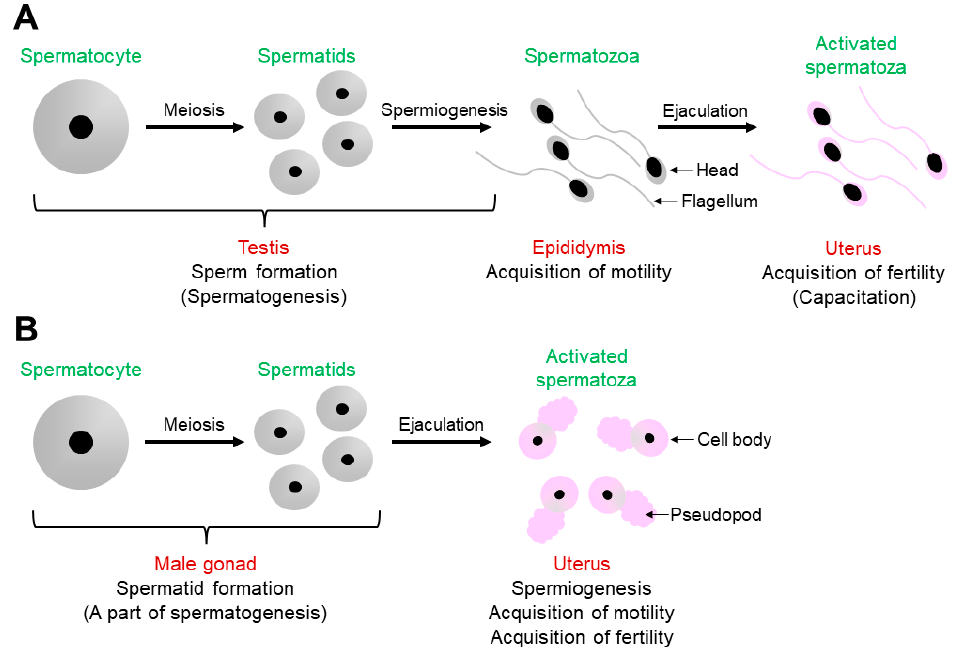
Figure 1. Comparison of sperm formation and activation in mice and C. elegans . ( A ) In the mouse testis, spermatozoa are produced during spermatogenesis. The testicular spermatozoa acquire their motility during transition in the epididymis. After ejaculation, the epididymal spermatozoa undergo capacitation to gain the ability to fertilize oocytes. ( B ) Meanwhile, in the C. elegans male gonad, round spermatids are produced via meiosis; however, spermatogenesis is arrested at this stage. After mating, in the uterus of hermaphrodites, spermatogenesis resumes, and ejaculated spermatids are then activated presumably by TRY-5, which is contained in ejaculated seminal fluids. This process is called spermiogenesis, during which spermatozoa acquire motility and fertility. Pink-colored spermatozoa indicate that they are fertilization-competent.